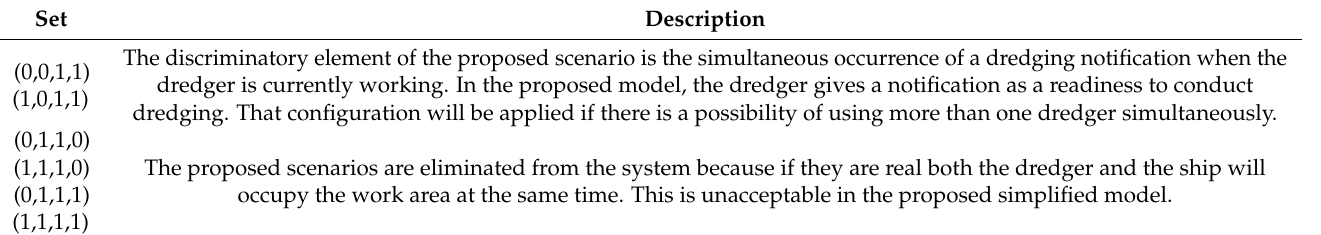
Table 4. Unacceptable (unrealistic) scenarios simulated in the